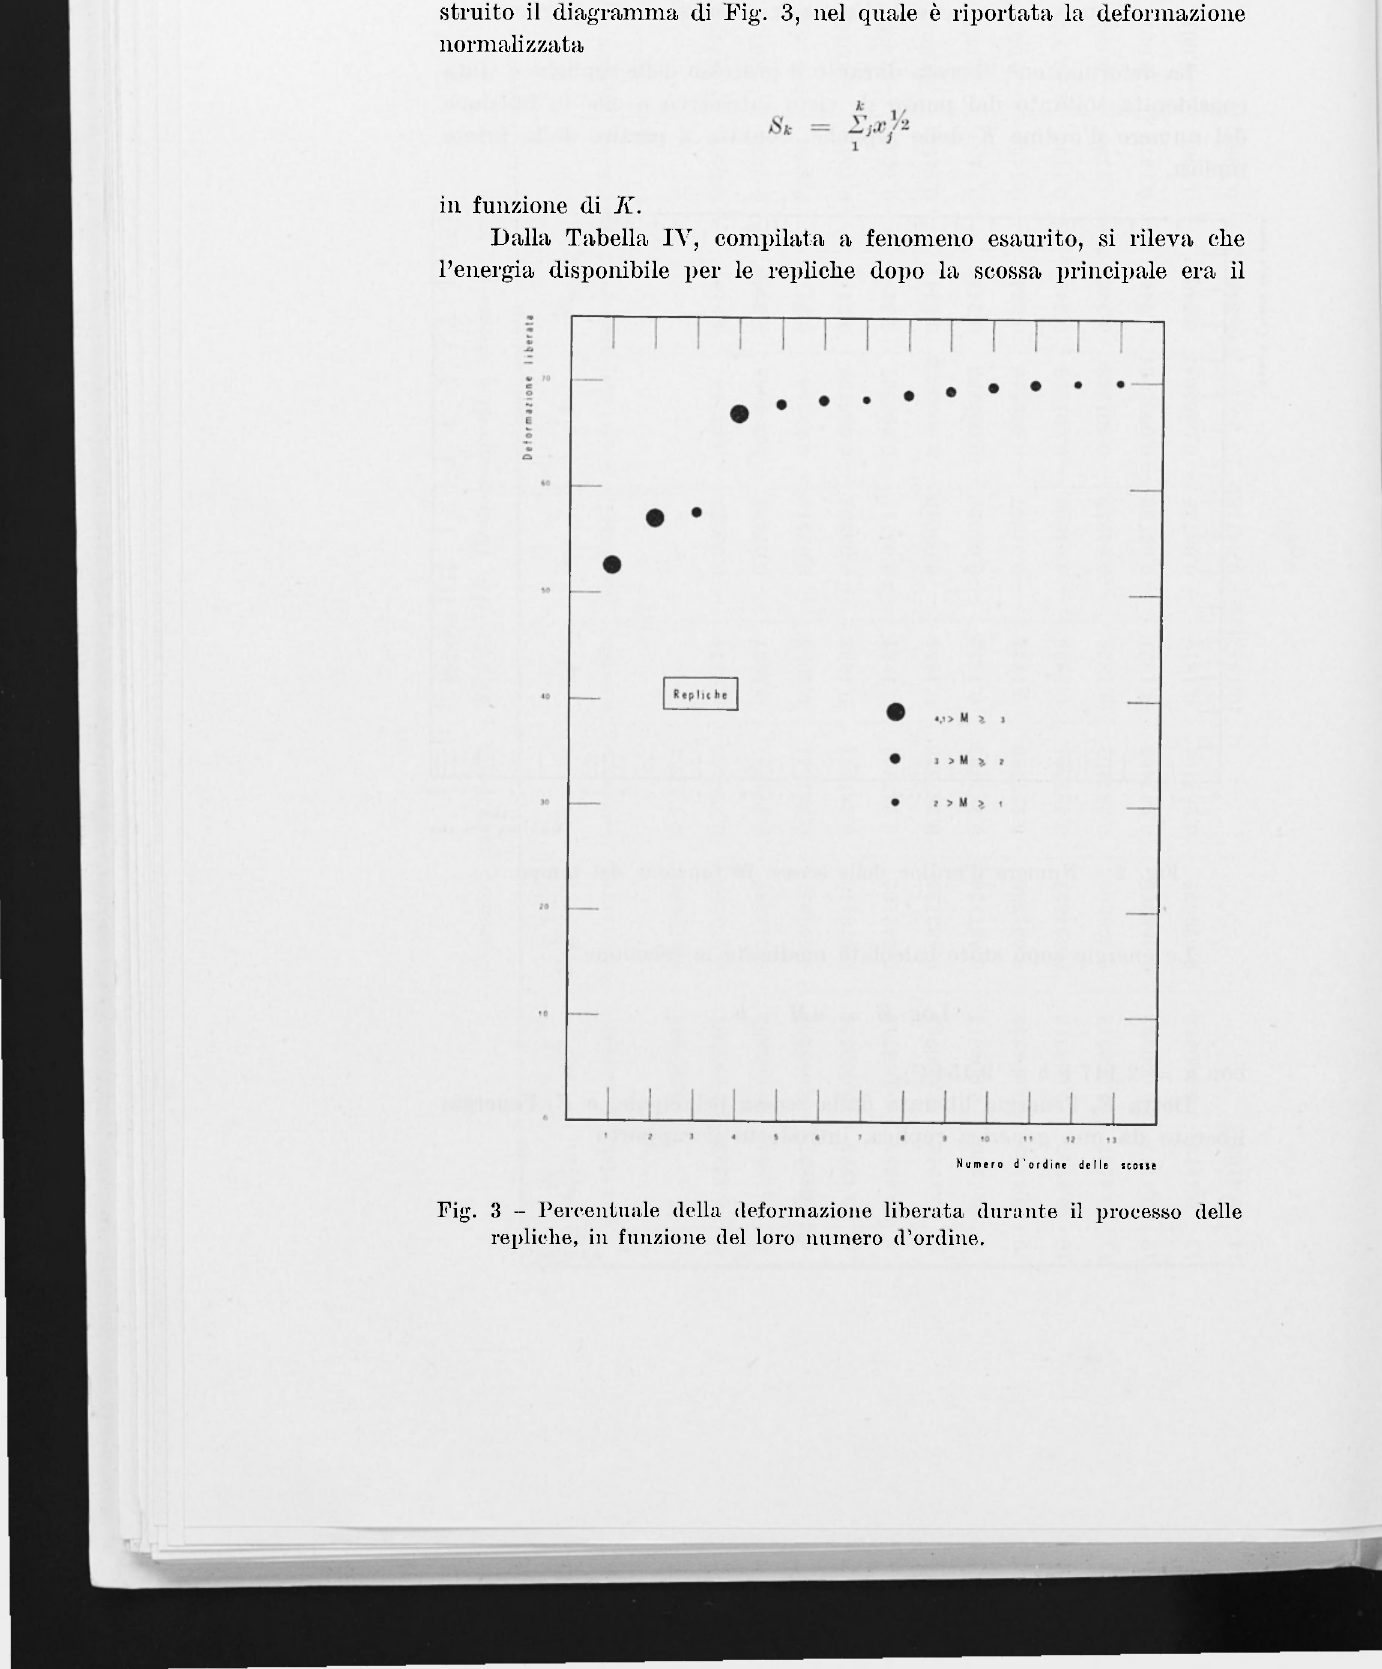
Fig. 3 - Percentuale della deformazione liberata durante il processo delle repliche, in funzione del loro numero